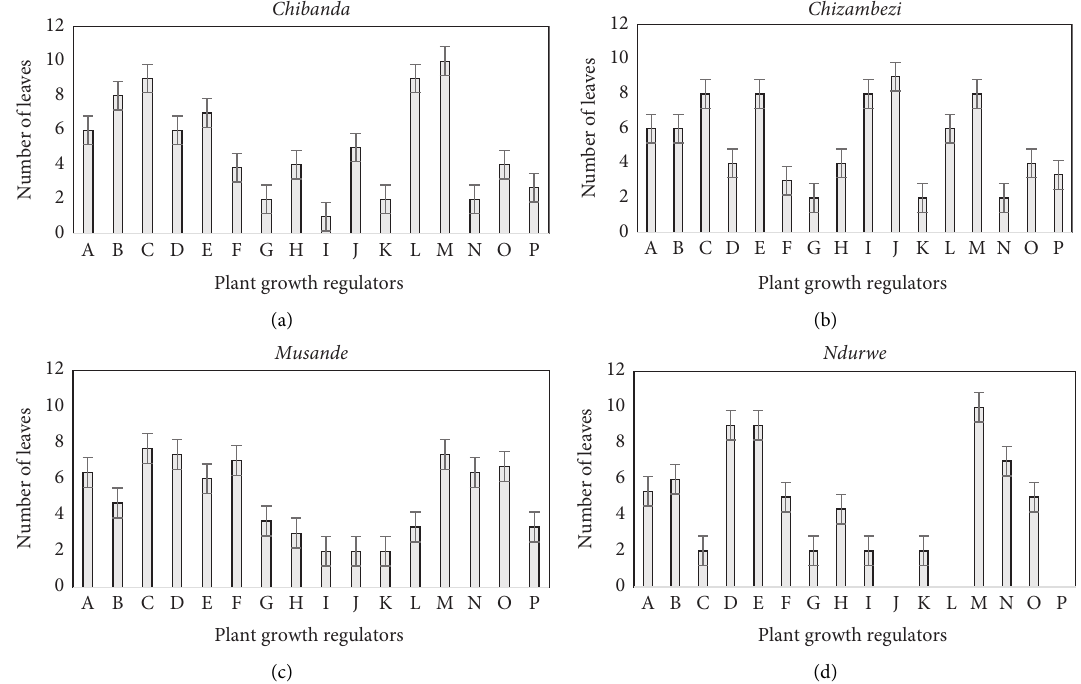
Figure 5: Mean node number of the Livingstone potato landraces in response to NAA: BAP in mg/l application. P < 0 . 001, LSD � 1.05. Error bars represent standard errors of the differences. Plant growth regulators key: A (0mg/l :0mg/l), B (0mg/l:0.5 mg/l), C (0mg/l :1mg/l), D (0mg/l: 2mg/l), E (0.2mg/l :0mg/l), F (0.2mg/l: 0.5mg/l), H (0.2mg/l:2 mg/l), I (0.5mg/l :0mg/l), J (0.5mg/l :0.5mg/l), J (0.5mg/l: 0.5mg/l), K (0.5mg/l:1 mg/l), L (0.5mg/l: 2mg/l), M (1mg/l :0mg/l), N (1mg/l :0.5mg/l), O (1mg/l:1 mg/l), and P (1mg/l